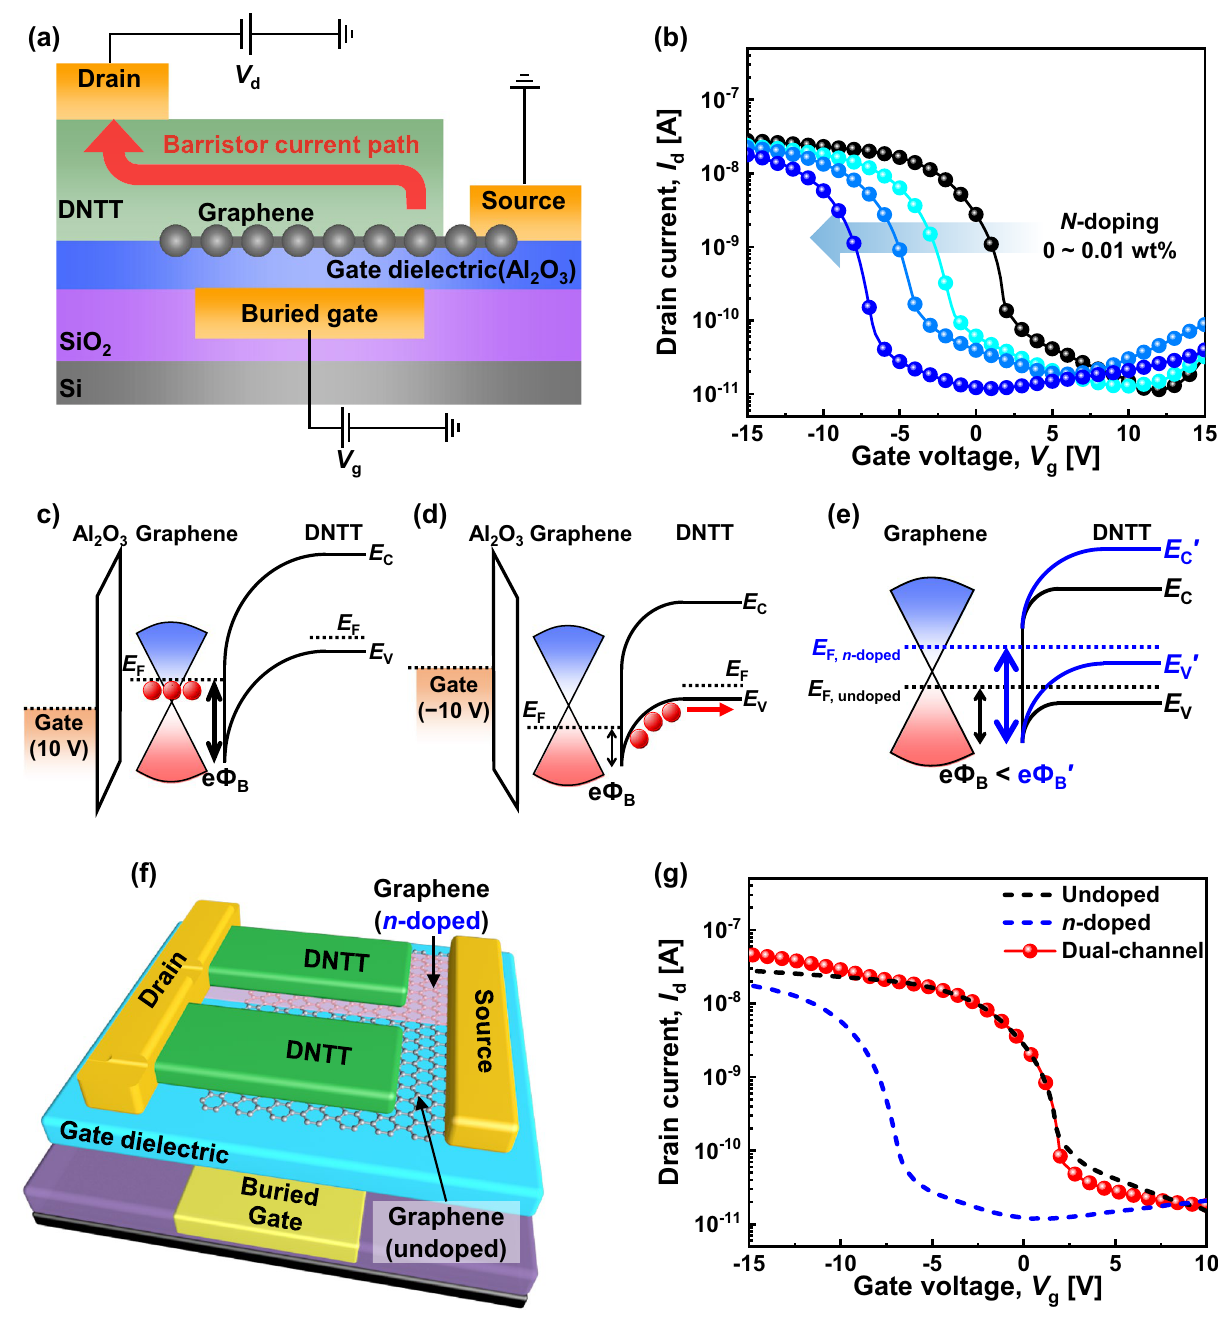
Figure 2. ( a ) Cross-sectional structure of graphene barristor with the direction of current flow. ( b ) Transfer curves for the p -type graphene barristor with PEI concentrations of 0 (no doping), 0.0025, 0.005, and 0.01 wt% at V d = − 2 V. Schematic band diagrams of graphene barristor at ( c ) V g = 10 V and ( d ) V g = − 10 V. ( e ) SBH difference between undoped and n -doped graphene barristors. ( f ) Schematic device structure of dual-channel p -type graphene barristor. ( g ) Transfer curves for single- and dual-channel devices at V d = − 2 Fig. 3a. After inserting the thin Al 2 O 3 layer, the drain current is slightly degraded, but the saturation portion of the I – V curve becomes more flat, as shown in Fig. 3b. We named this layer a CRL. Because the CRL does not interfere with the Schottky junction between the graphene and DNTT, V th of the device is minimally affected. Second, it was required to improve the on-current level of the graphene channel with high V th to obtain a more distinct level 2. In this case, the carrier concentration of the DNTT needed to be higher to reduce the contact resistance, and hence, F 4 TCNQ, which is a p -type dopant for DNTT, was employed. F 4 TCNQ improves the conductivity of DNTT by creating an additional hole carrier in the DNTT region. F 4 TCNQ was thermally co-evaporated with DNTT at a 7:1 ratio. This 10-nm-thick F 4 TCNQ layer, which is called a CDL, effectively lowers the hole injection barrier between Au and DNTT and enhances the current flow through the DNTT 32–34 .